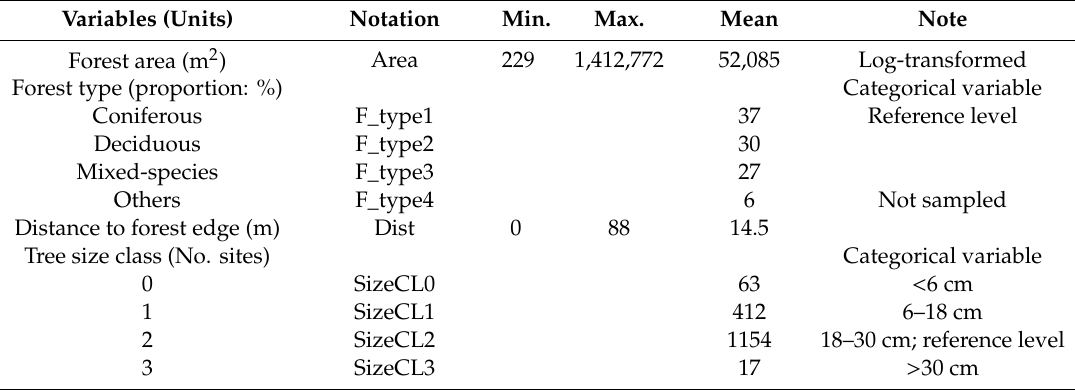
Table 1. Description of forest condition